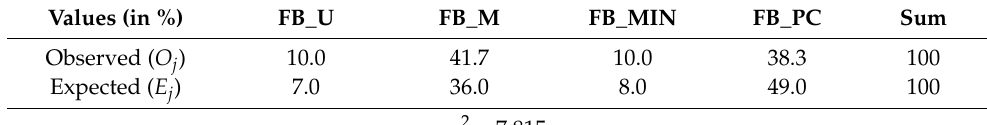
Table 1. Verification of χ 2 test of homogeneity.